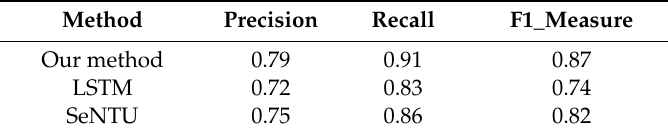
Table 5. Evaluation of the sequential emotion analysis